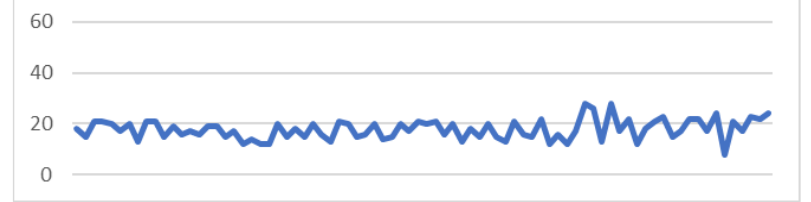
Figure 9. Time delay between CAM message and driver notification on the equipped HMI display in ms.